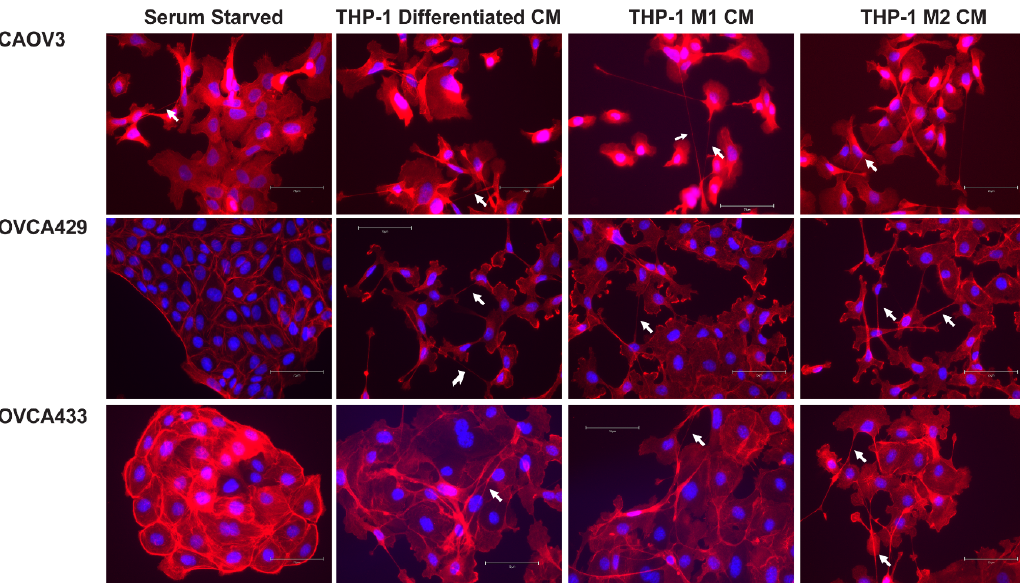
Figure 2. Macrophages alter cellular morphology of ovarian cancer cells during co-culture. THP-1 cells were differentiated and/or differentiated followed by subsequent polarization to M1 and M2 macrophages. After differentiation/polarization CAOV3, OVCA429, and OVCA433 cells were cultured with differentiated THP-1, M1, and M2 polarized macrophages for 48 h. Cultures were stained for CD14 to denote THP-1 derived cells (green), Texas Red Phalloidin as a marker of F-actin (red), and DAPI (blue). 20× original magnification. Scale bar = 150 µm. Arrow = denotes membrane projections produced between tumor cells.